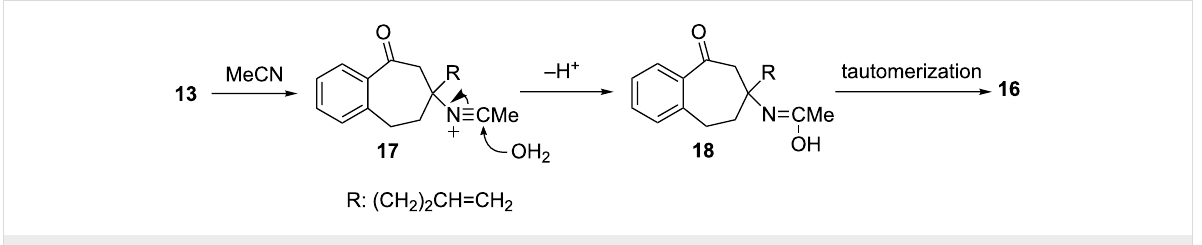
Scheme 9: Formation of acetoamide 16 from the cation 13 .